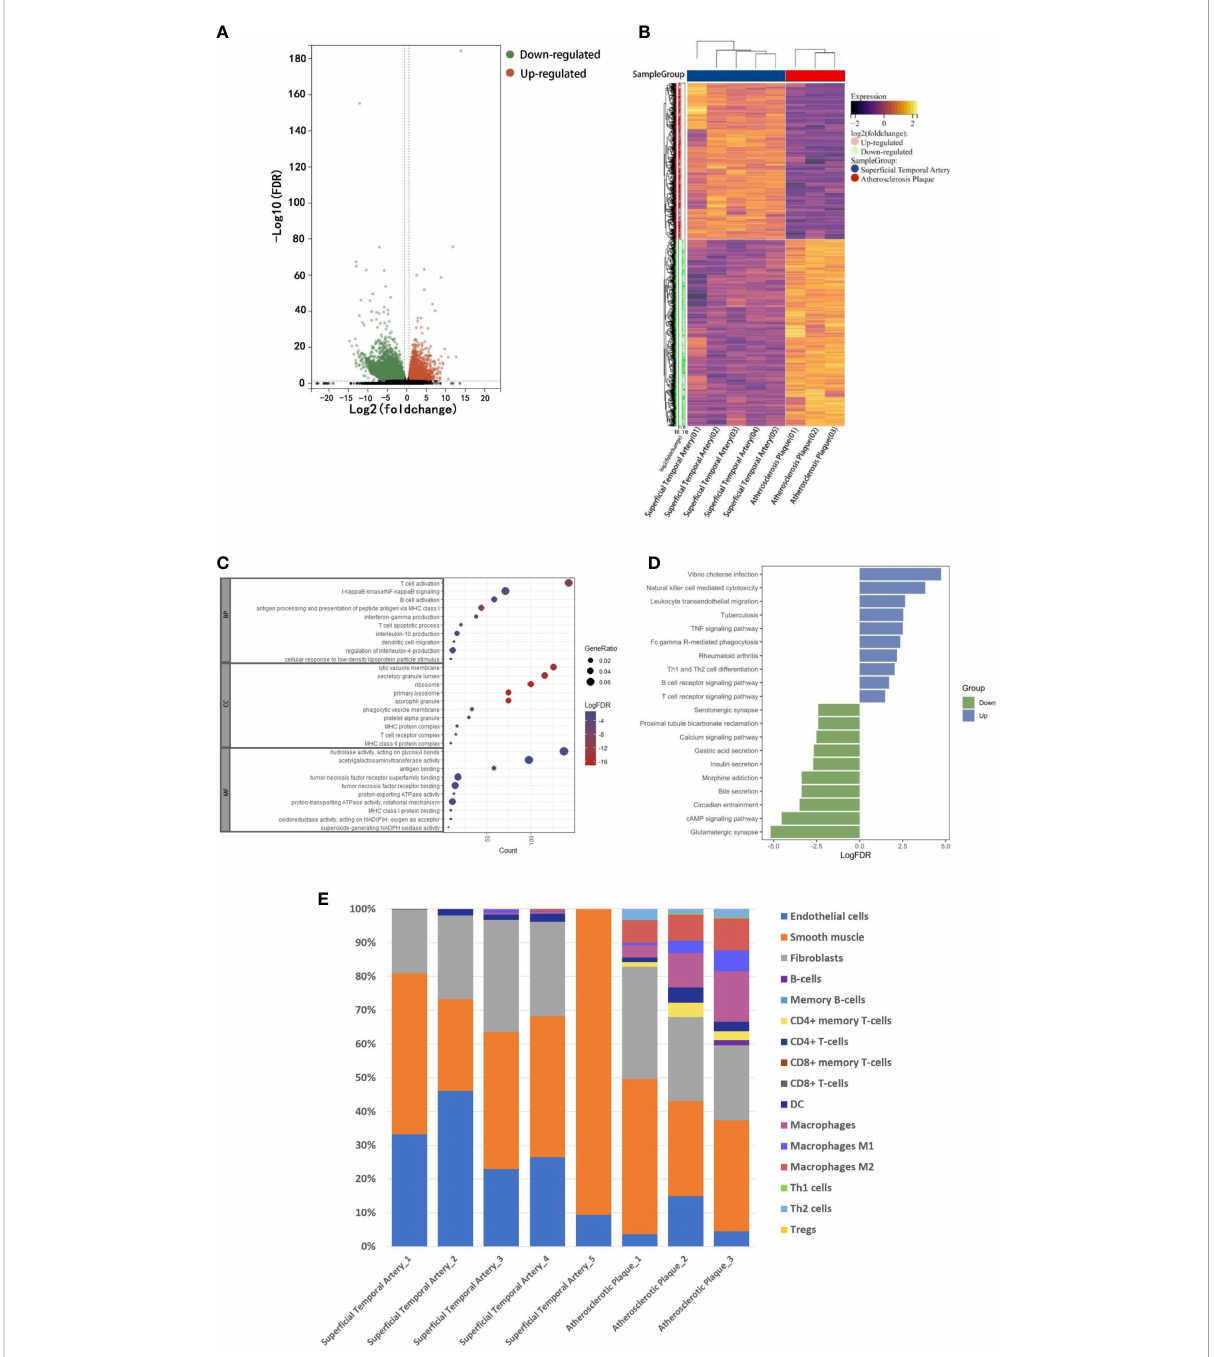
FIGURE 1 RNA-seq analysis. A: The RNA-seq data of normal super fi cial temporal arteries and plaques were compared. The differential genes were shown by volcanic map (A) and heatmap (B) . (C) Bubble map shown the GO enrichment results of up-regulated genes in plaques. (D) Histogram shown KEEG pathway enrichment results of up-regulated and down-regulated genes in plaques. (E) Immune in fi ltration analysis revealed the composition of super fi cial temporal arteries and atherosclerotic